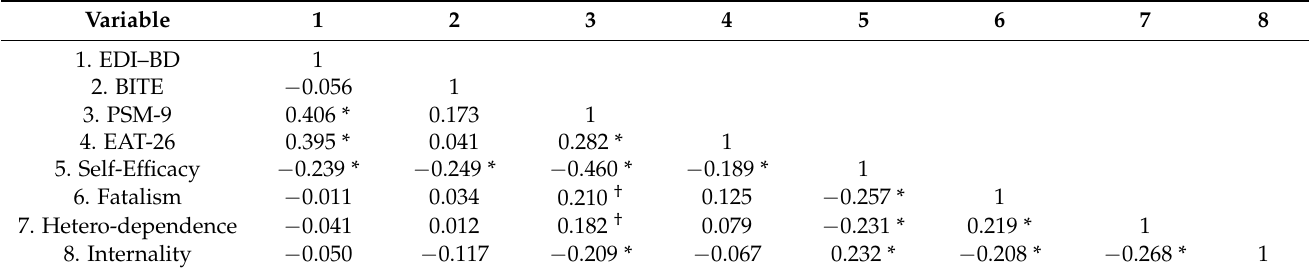
Table 3. Correlation Coefficients (Pearson’s